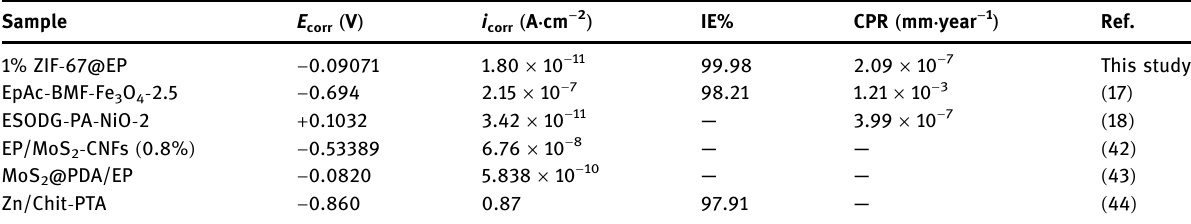
Table 2: Comparison with other inorganic fi ller - based polymer anticorrosion coatings studied